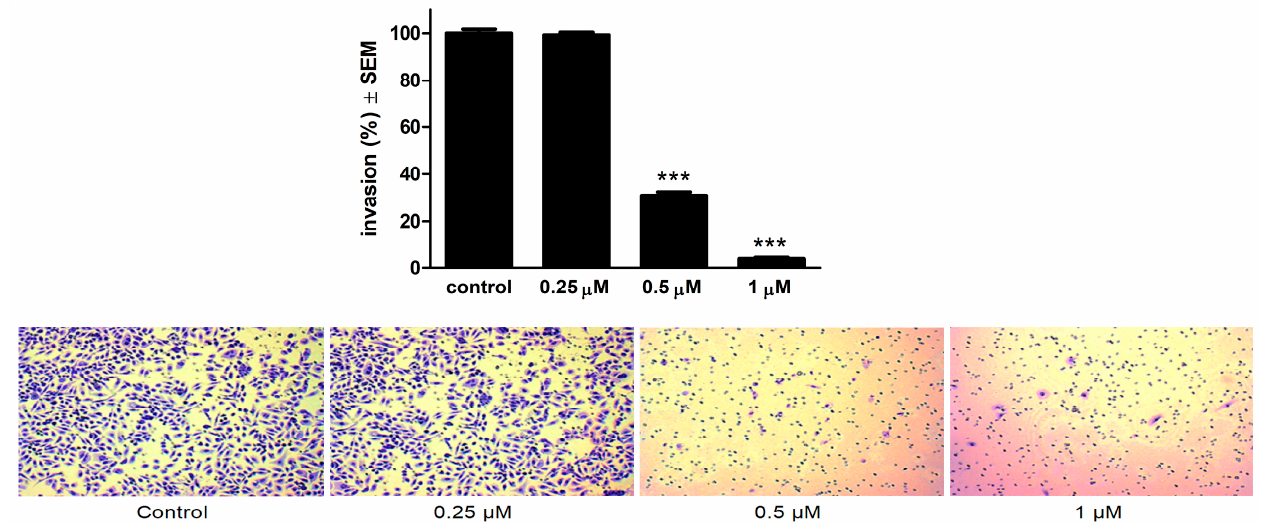
Figure 8. 13AES3 elicited a significant anti-invasive effect on SiHa cells, at subantiproliferative concentrations. Upper panel : anti-invasive effect of 13AES3 at 24 h post-treatment. *** indicates significance at p < 0.001. Lower panel : microscopic images showing the density of invasive cancer cells after crystal violet staining (10× magnification).